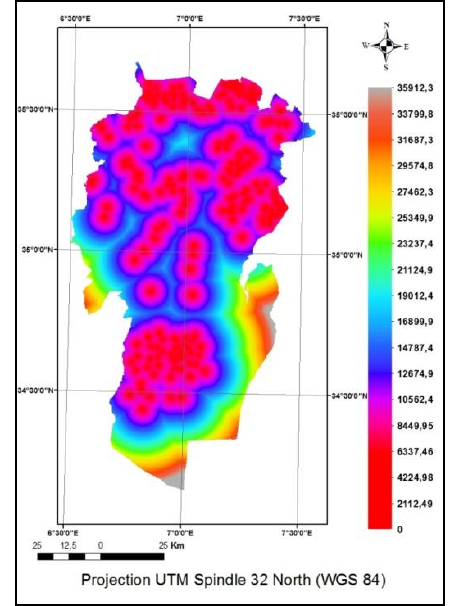
Figure 4: Map of the distances (in meters) relative to the water resources.